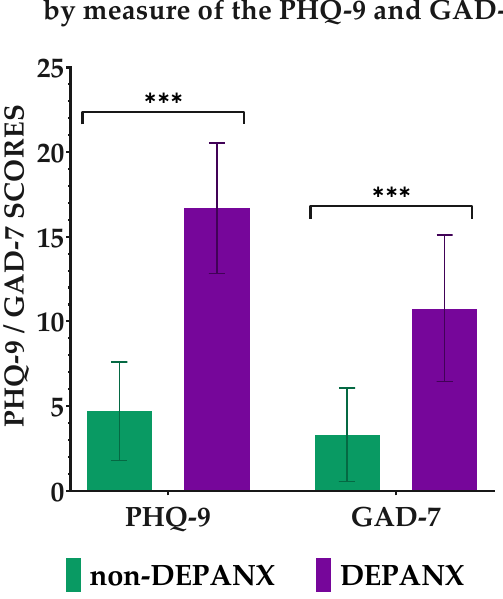
Figure 1. Depression and anxiety status by measure of the PHQ-9 and GAD-7. Results are shown for the two groups ‘non-DEPANX’ ( n = 702) and ‘DEPANX’ ( n = 349). Stars indicate level of significance of p-values. ***: p < 0.001.